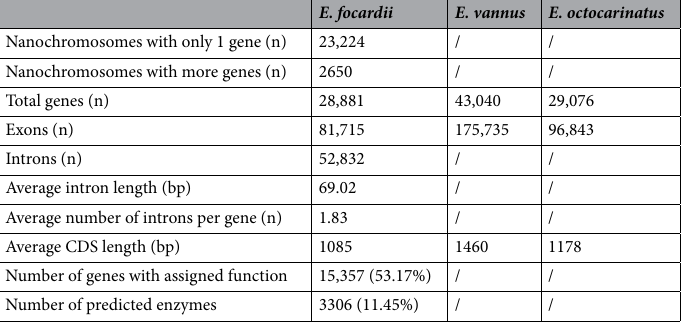
(Fig. S1). The final GC distribution shows a well-defined peak (with respect to the distribution before clean- ing) centered on the 31.51% (Table 1, Fig. S2), a value consistent with those reported for other ciliates with a